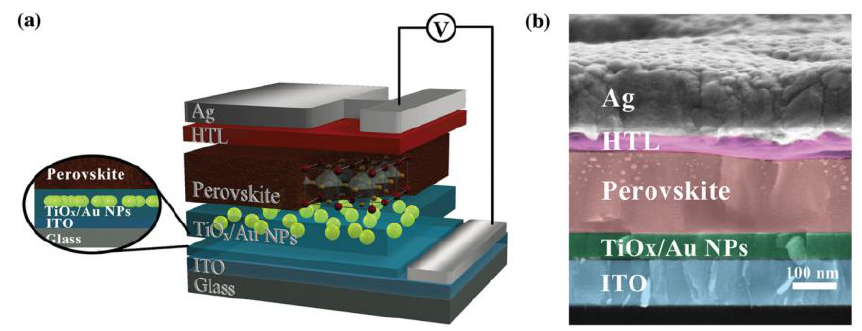
Figure 11. ( a ) Schematic of the (ITO/TiO x –Au-NPs/CH 3 NH 3 PbI 3-x Cl x /HTL/Ag) device structure. Gold-NPs are embedded between two TiO x layers. HTL can be either P3HT or Sprio-OMeTAD. ( b ) Cross-sectional SEM image of the device. Reproduced with permission from Ref. [118]. Table 5. Electrical output characteristics of the devices with P3HT and Spiro-OMeTAD as HTLs. HTL